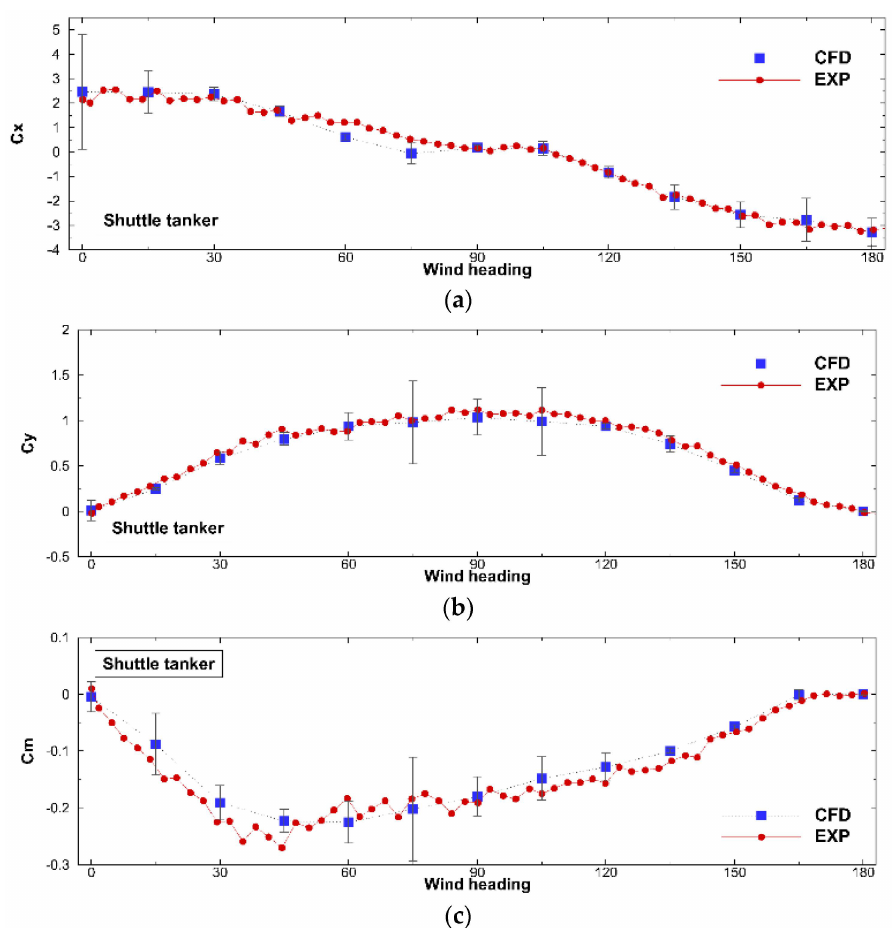
Figure 11. Comparison of aerodynamic coefficients for the shuttle tanker. (a) 𝐶 𝑥 ; ( b ) 𝐶 𝑦 ; ( c ) 𝐶 𝑚 .